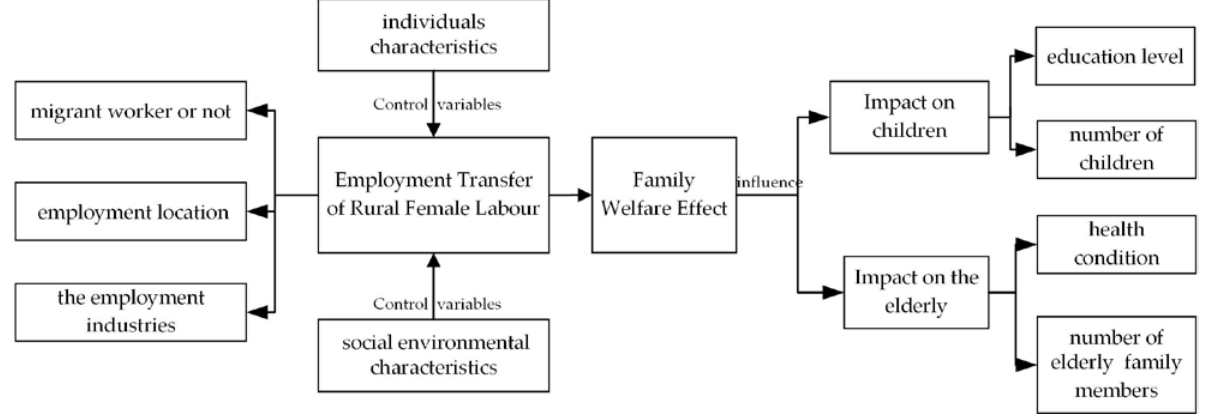
Figure 2. Family welfare effect model of rural women’s employment transfer.